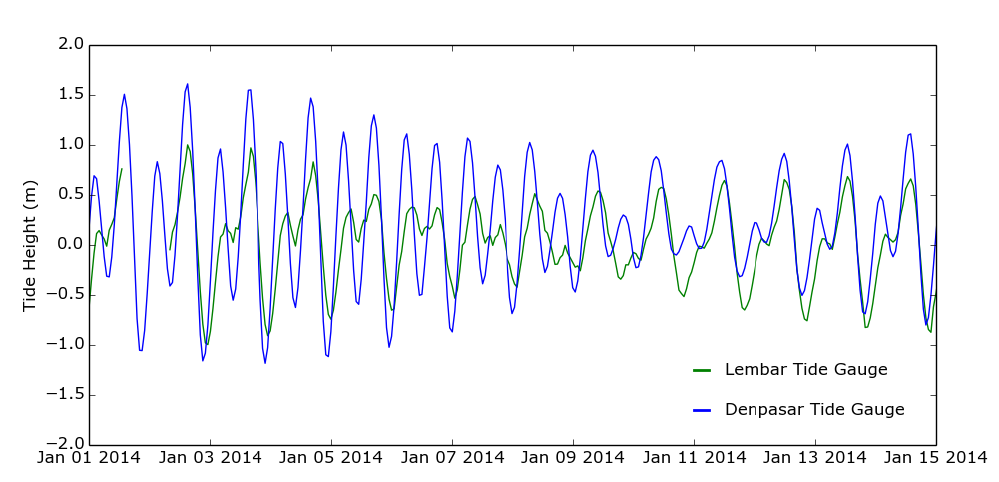
Figure 4. Comparison of tide gauge